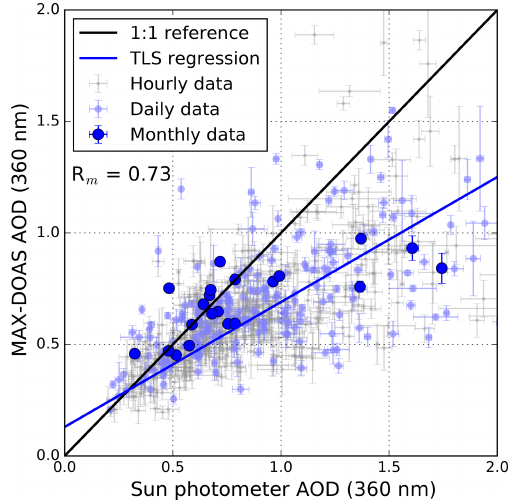
Figure 3. Comparison of AOD measured by the MAX-DOAS and sun photometer. The total least squares regression line is calculated based on the daily